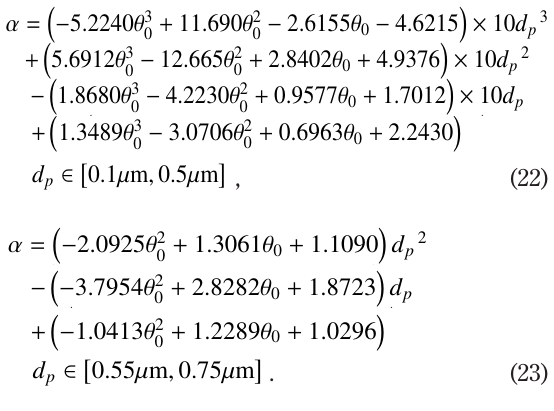
and s at the stage of m f